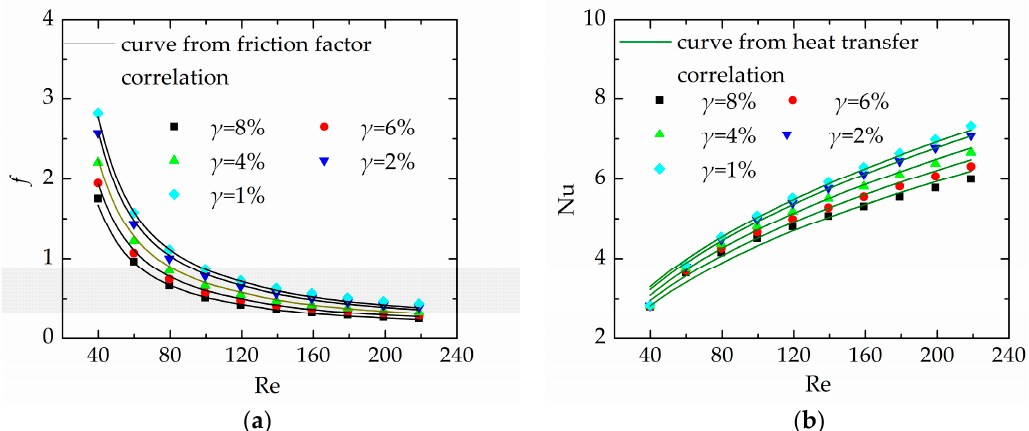
Figure 4. Variations in the ( a ) f and ( b ) Nu with the Re at various pin diameter degressive gradients for T in = 300 K and q = 10,000 W/m 2 .